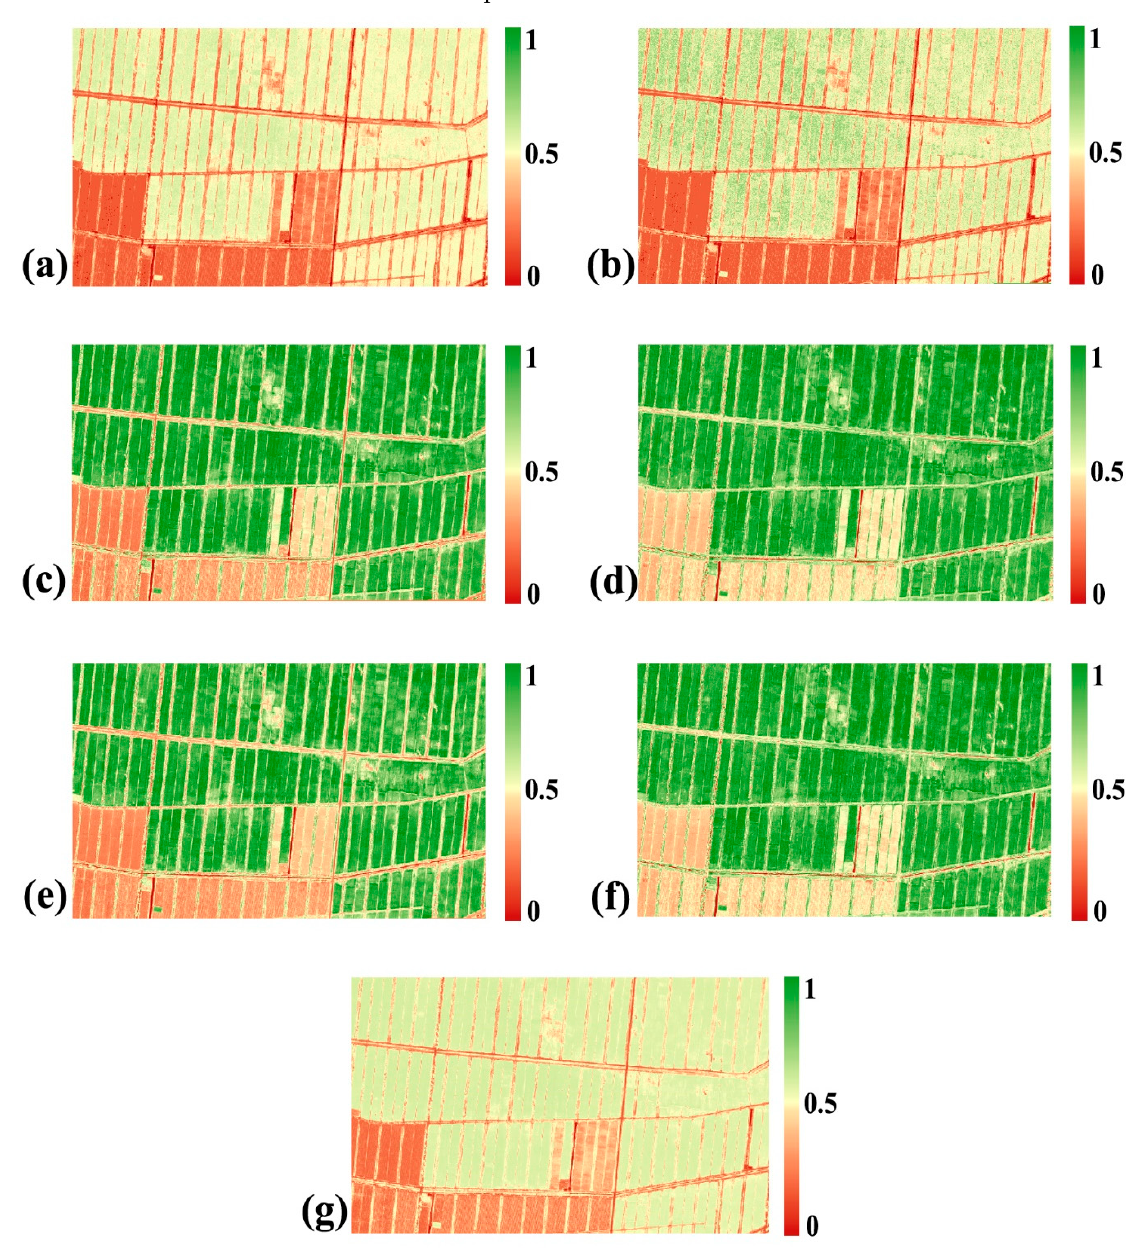
Figure 4. The images of FVC of row crops estimated from the different algorithms for the World-View 3. ( a ) MFS + BPNN, ( b ) PROSAIL + BPNN ( c ) U-SMA-2, ( d ) C-SMA-2, ( e ) U-SMA-5, ( f ) C-SMA-5, and ( g ) empirical